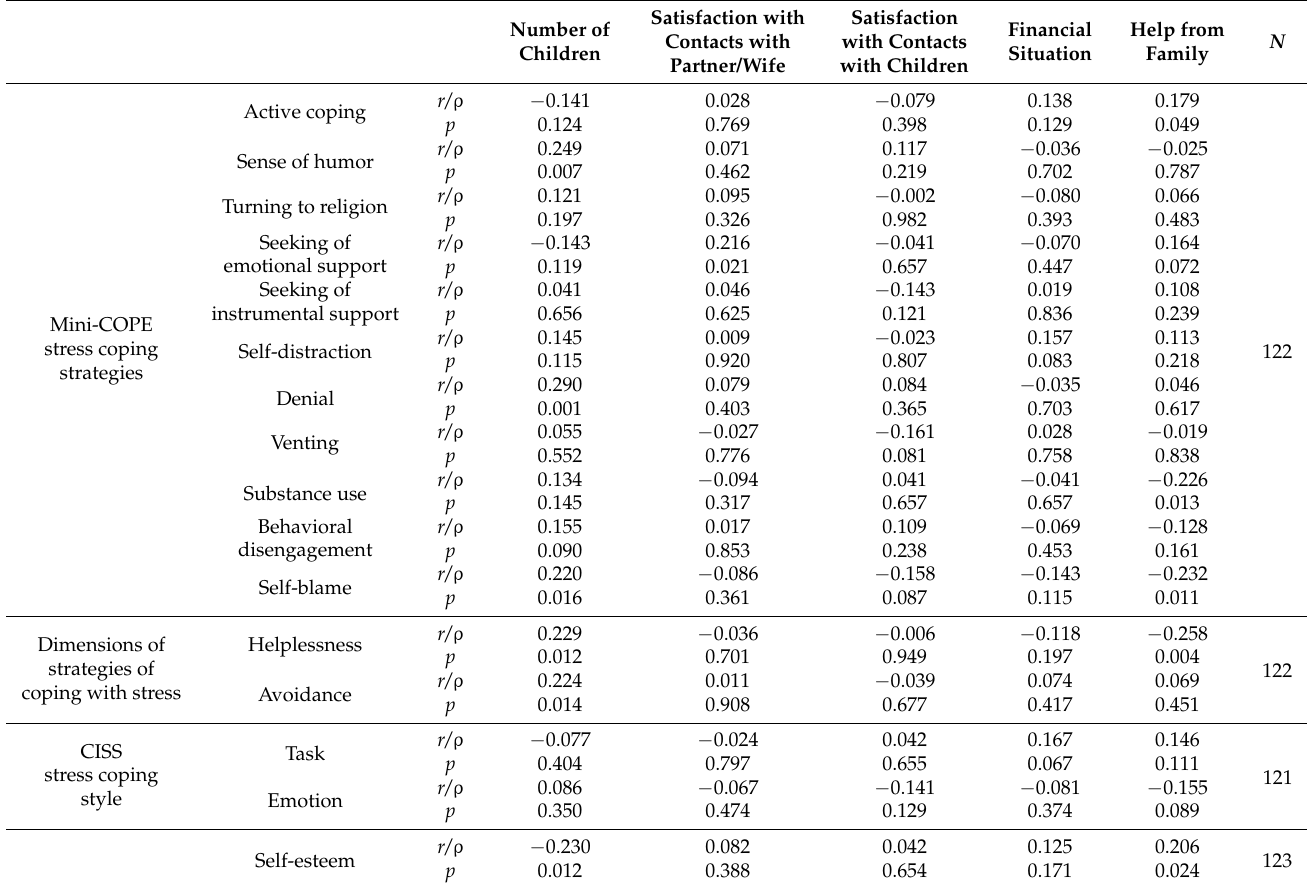
Table 3. Associations between sociodemographic factors, stress coping strategies and dimensions of styles of coping. Satisfaction with Satisfaction Number of Financial Help from Contacts with with Contacts Children Situation Family Partner/Wife with Children